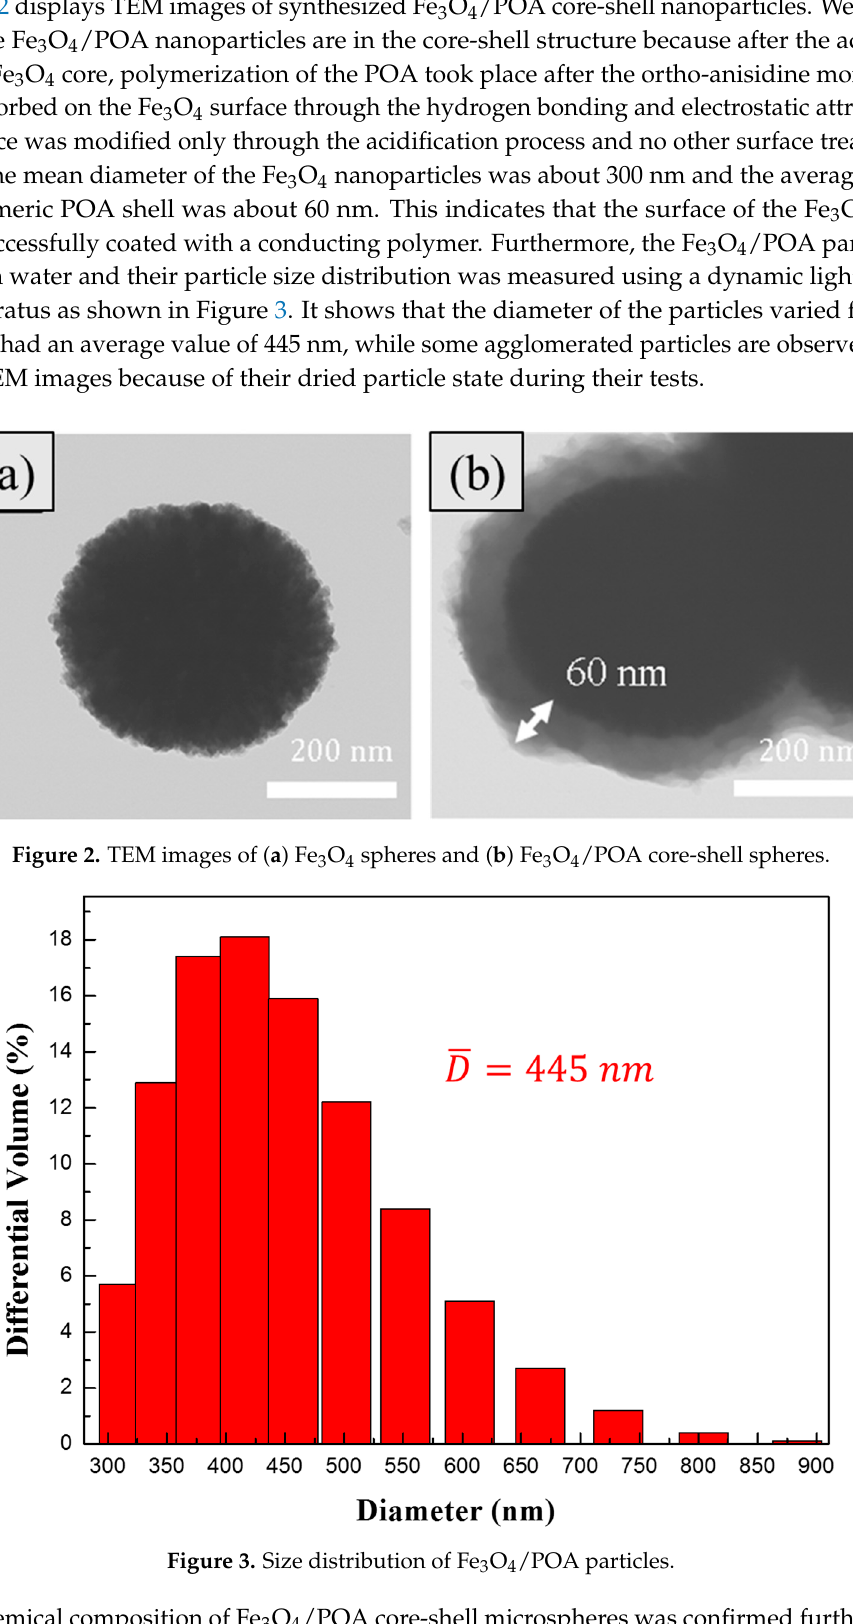
Table 2. EDAX data of Fe 3 O 4 /POA spheres.